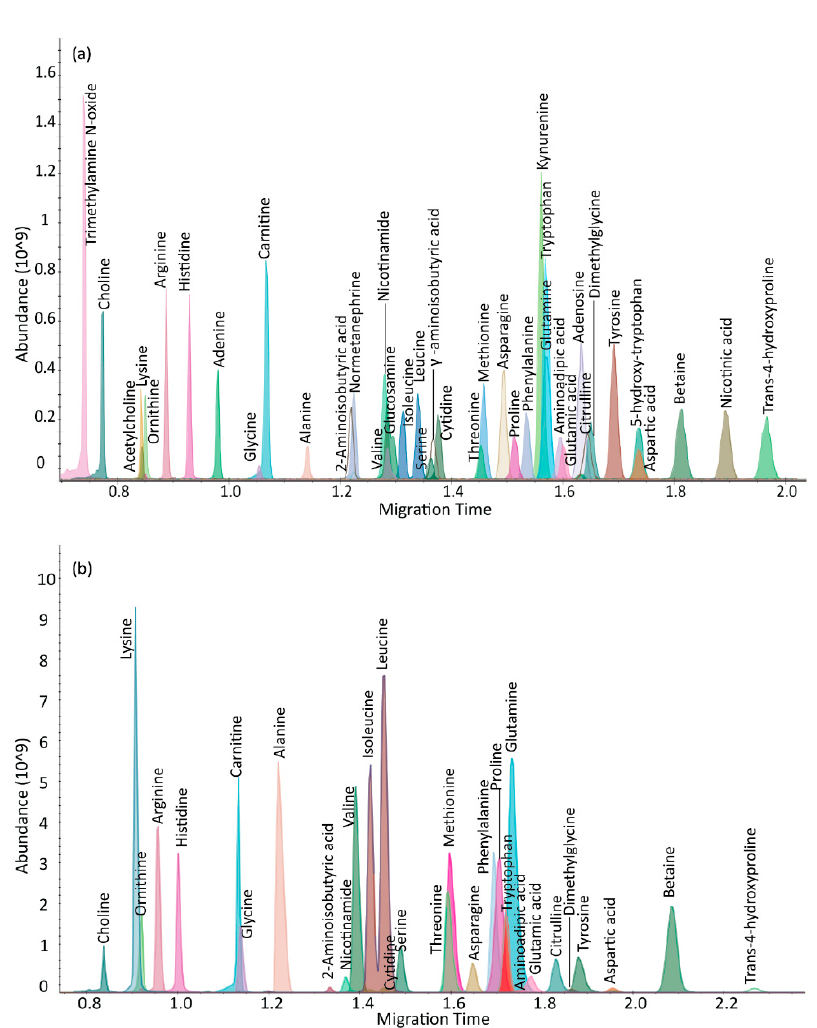
Figure 1. µCE-HRMS analysis in full scan mode. Extracted ion electropherogram (XIE) for ( a ) 40 target metabolites analyzed in a synthetic mixture and ( b ) 30 metabolites detected in a TKO mouse serum extract sample. The x -axis represents the migration time in minutes and the y -axis shows the MS peak abundance.